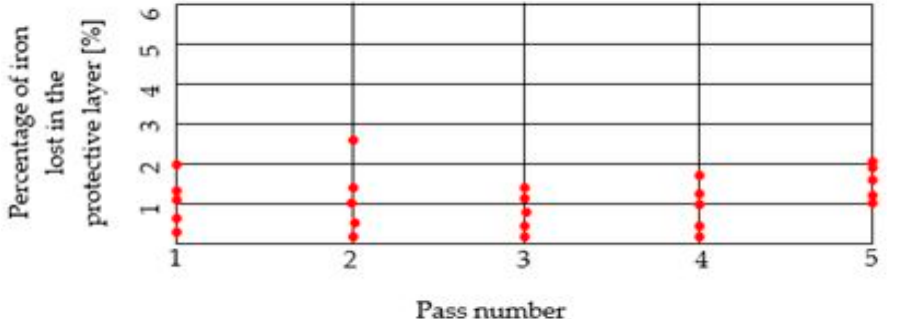
Figure 9. The evolution of Fe percentage lost in the steel wiredrawing process (variant 2 of the protective layer).